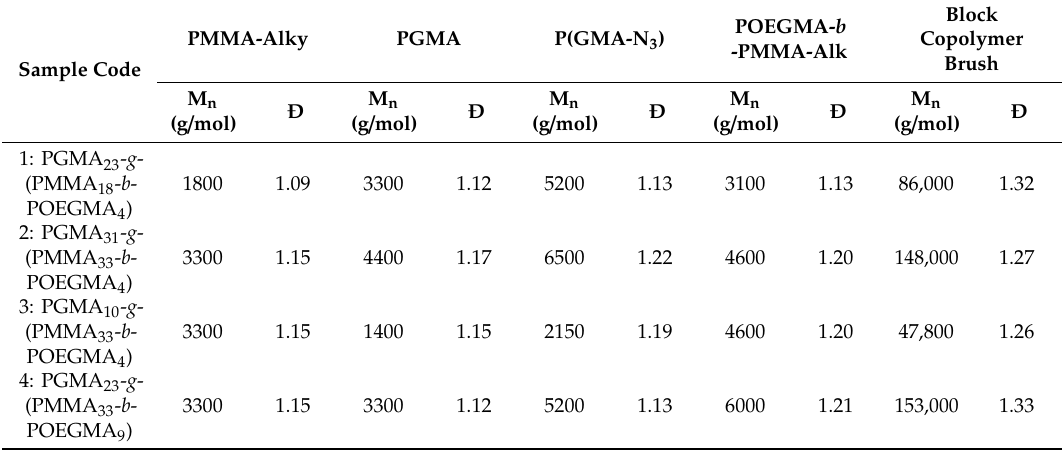
Table 1. Structural characteristics of all brush block copolymers. POEGMA- b -PMMA, poly(oligo(ethylene glycol) methyl ether methacrylate)- b -poly(methyl methacrylate); PGMA, poly(glycidyl